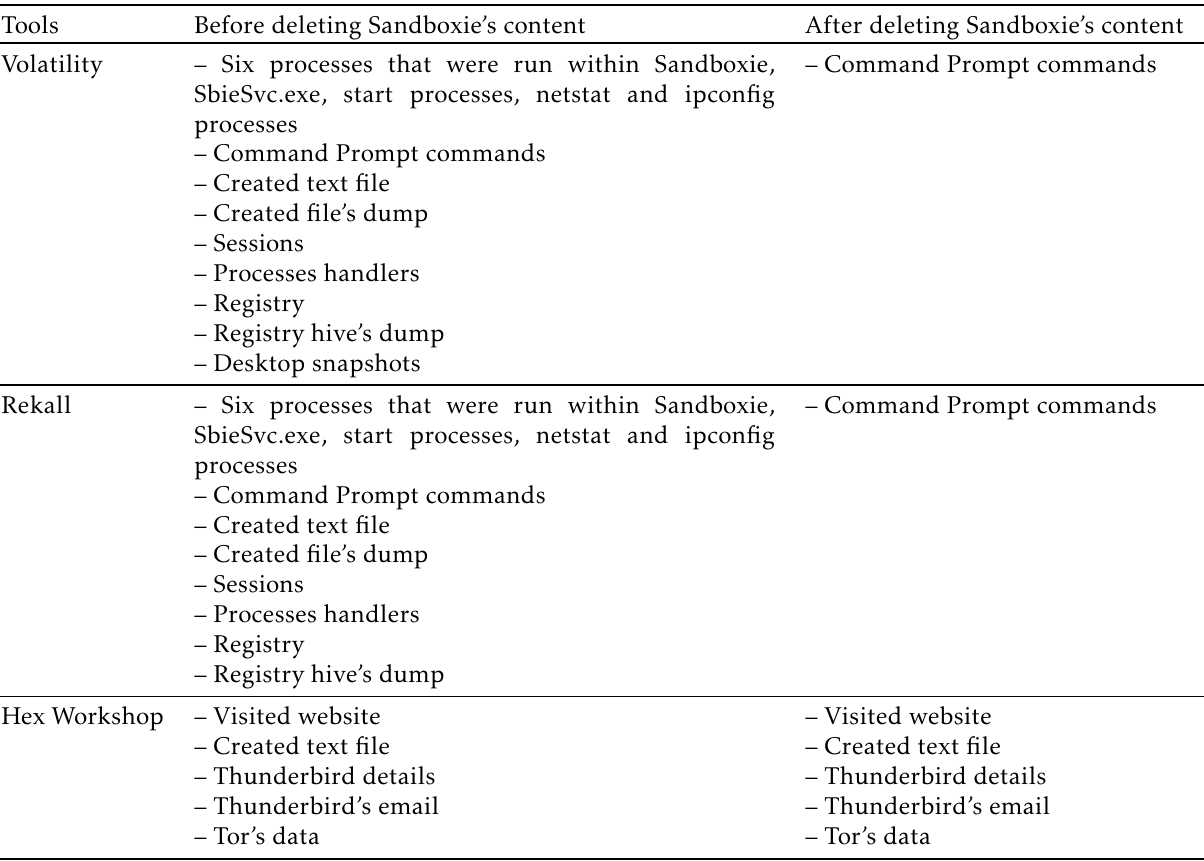
Table 9. Analysis results of the Sandboxie